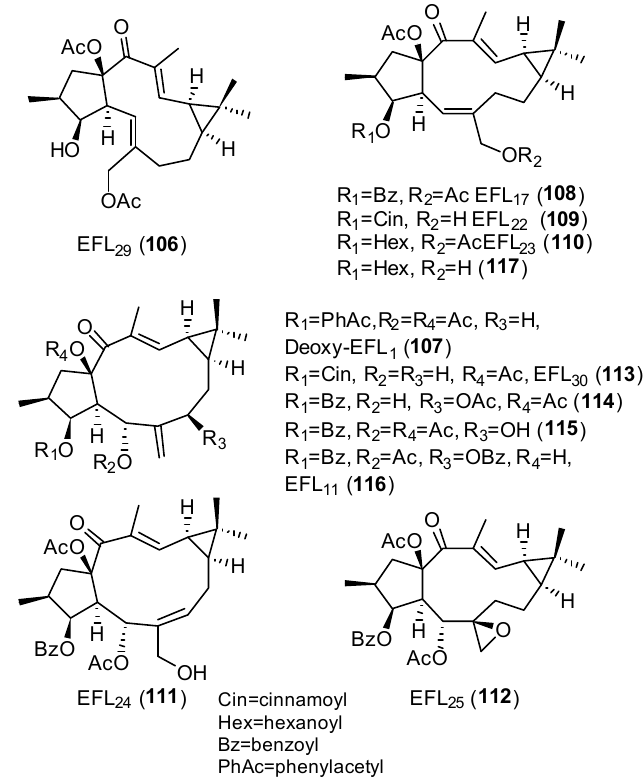
Figure 18. Structure of compounds 106 – 117 .